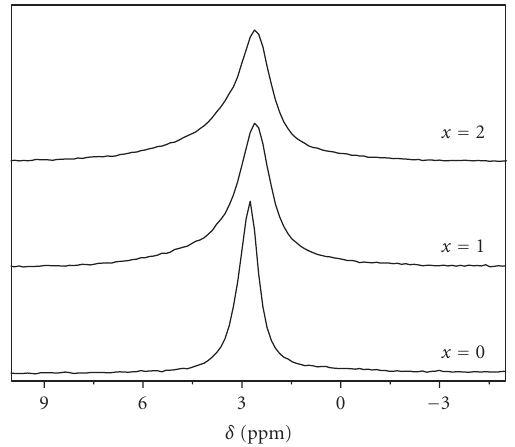
Figure 2: 31 P MAS NMR spectra of M x FA powders.